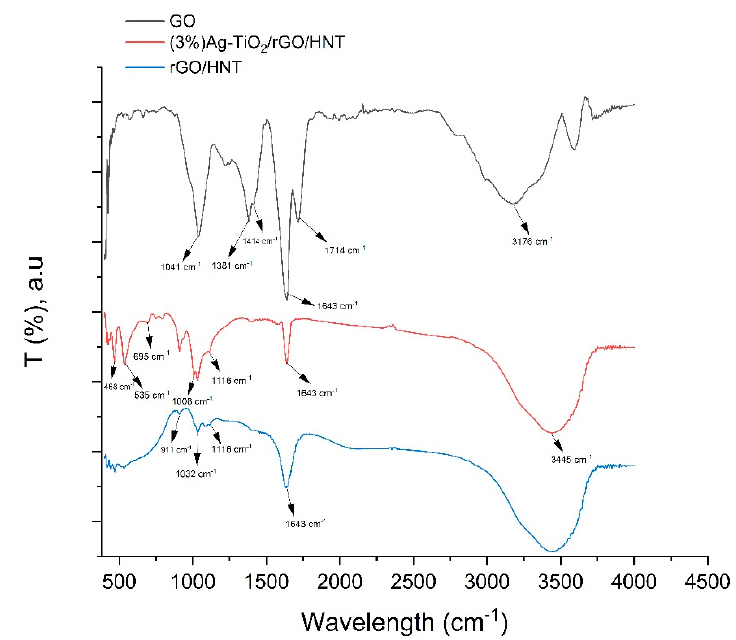
Figure 2. FTIR spectra of different samples.